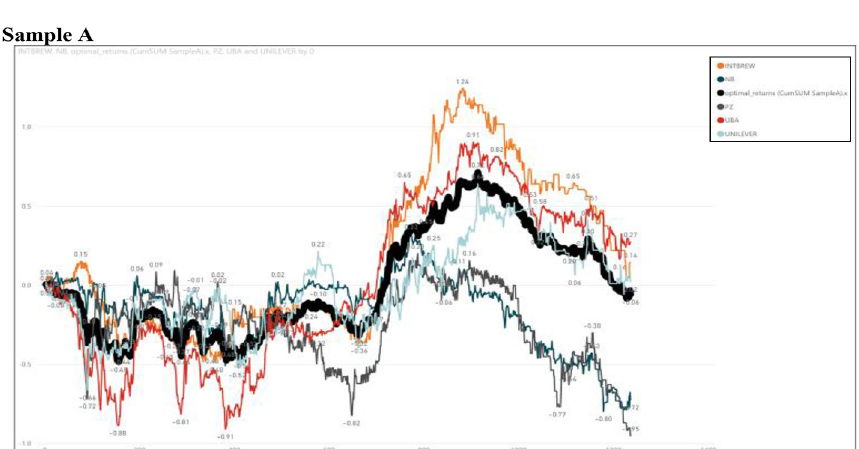
Figure 3. Optimalreturnsagainst individualreturns,